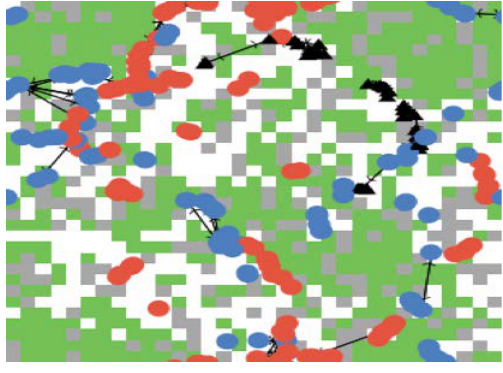
Figure 2. Some agents commit (A